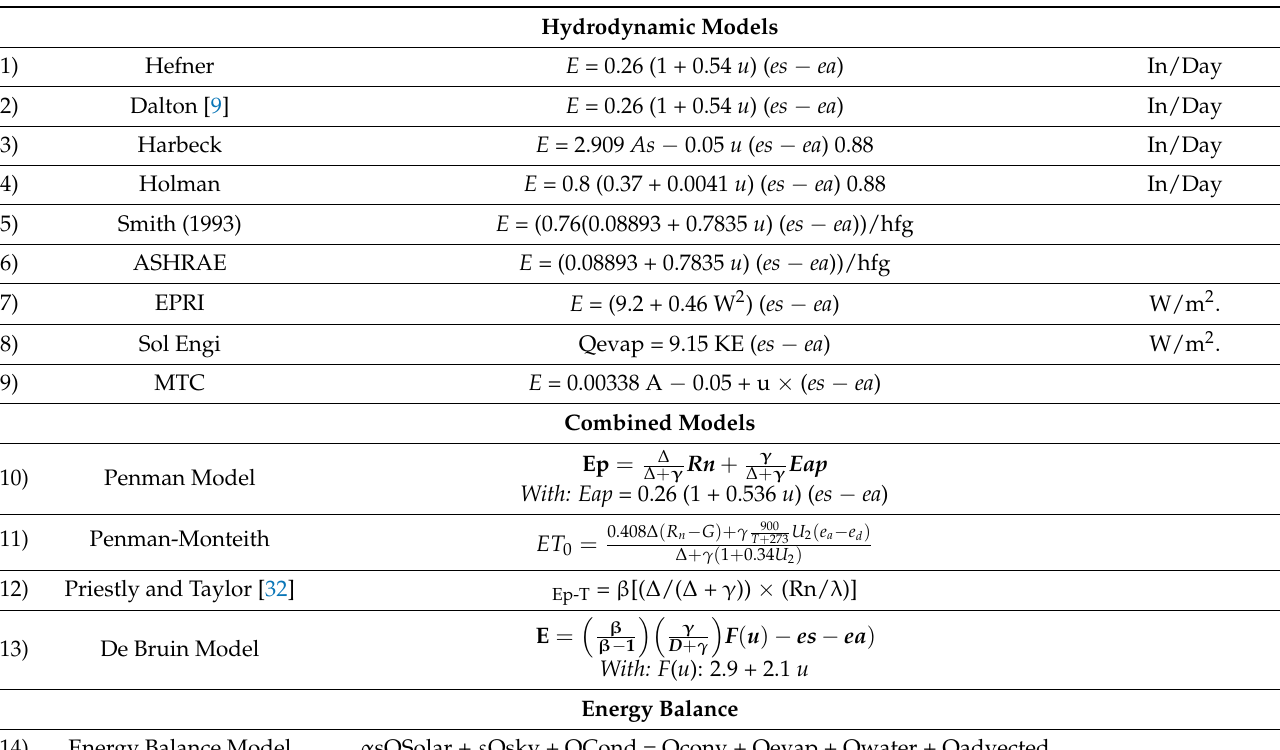
Table 1. Summary of formulas used for the calculation of evaporation (at the Thomas Pond). Hydrodynamic